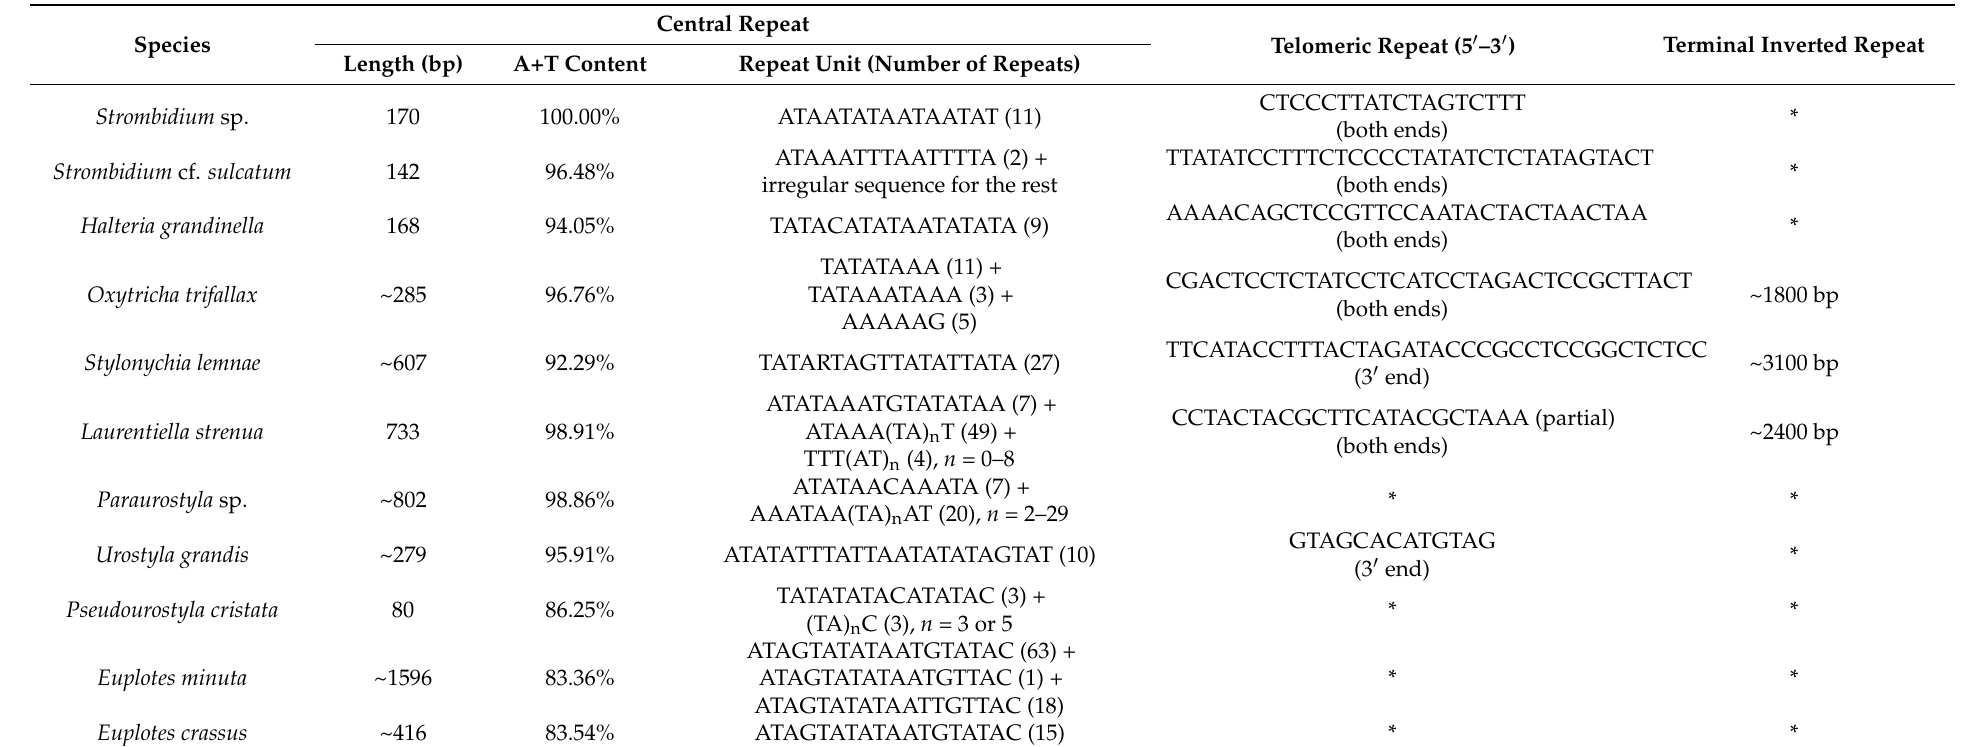
Table 2. Information of mitogenome repeats within the class Spirotrichea. * Denotes